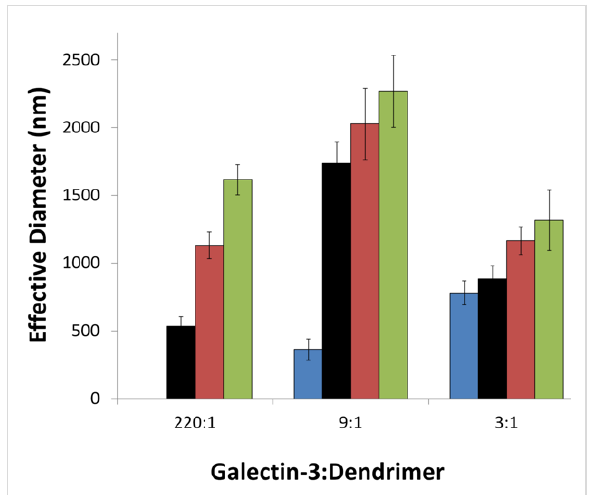
Figure 1: Effective diameter of galectin-3/glycodendrimer aggregates (DLS). Final concentration of galectin-3 31 μ M; final concentration of glycodendrimers 0.14, 3.3, 11.5 μ M for 220:1, 9:1, 3:1, respectively. 2 (blue), 3 (black), 4 (red) and 5 (green). Aggregate size was below the detection limit for 2 at 0.14 μ M.